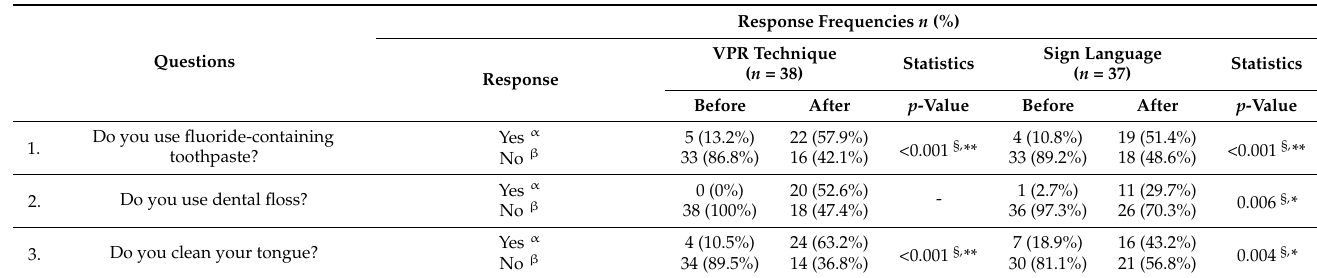
Table 2. Comparison of oral hygiene practices in the study population, before and after the interven- tion with the VPR technique and the sign language